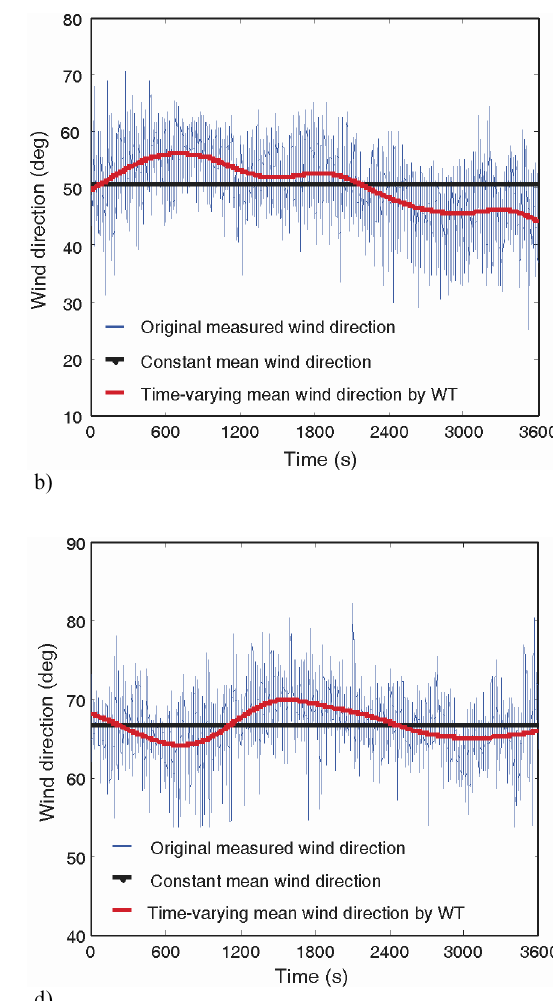
Fig. 3. Typical wind speed and wind direction samples and their time-varying and hourly mean wind speeds: (a) deck level wind speed sample (16:51–17:51, 1 April 2003); (b) deck level wind direction sample (16:51–17:51, 1 April 2003); (c) tower top wind speed sample (16:51–17:51, 1 April 2003); (d) tower top wind direction sample (16:51–17:51, 1 April